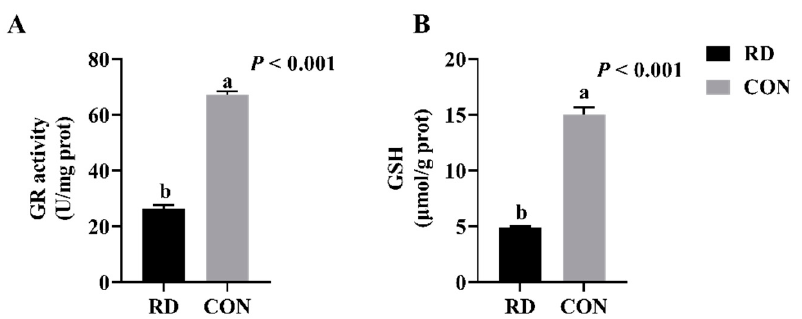
Figure 2. RD decreases glutathione reductase (GR) activity and glutathione (GSH) content. ( A ) GR activity of HepG2 cells cultured at 4 d. ( B ) GSH content of HepG2 cells cultured at 4 d. Values are means ± SD. Different letters indicate significant differences ( p < 0.05). Each treatment is performed in six replicates ( n = 6).